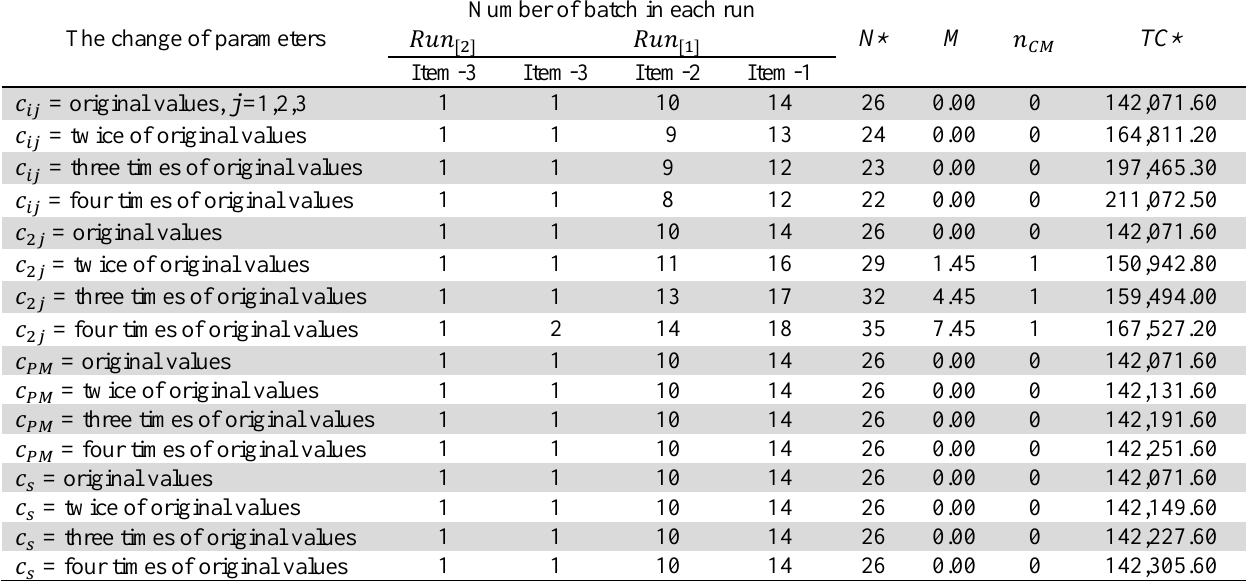
Table 7 Sensitivity analysis for Model